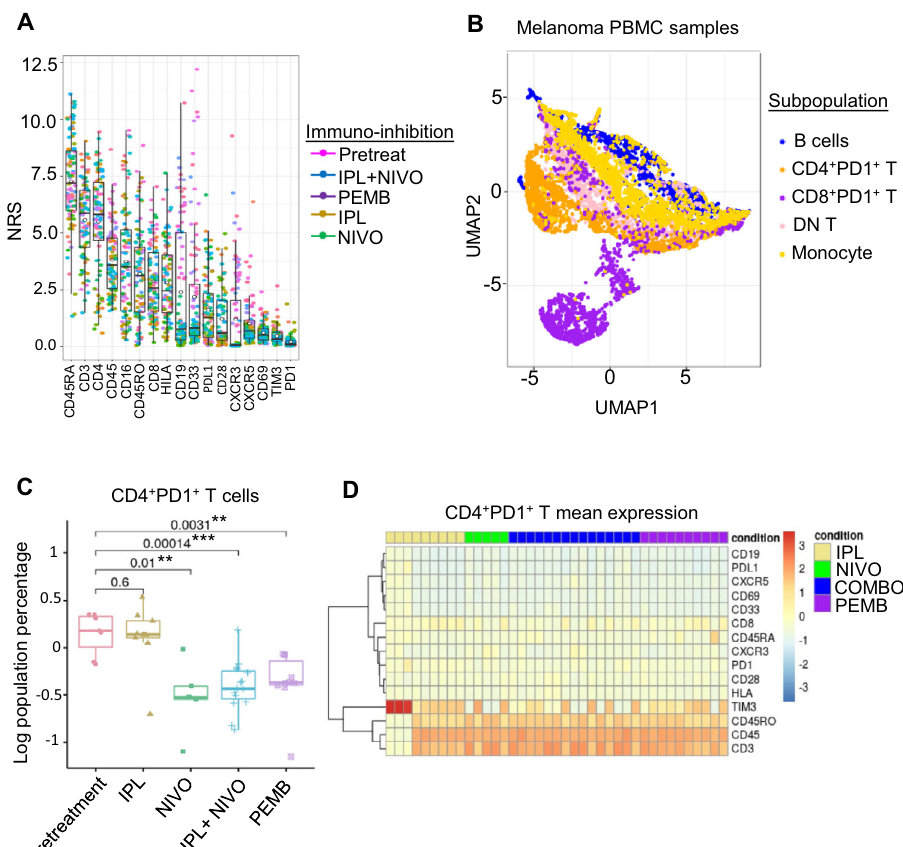
Fig. 7 Integration of melanoma datasets to uncover cellular correlates of immunotherapy. A Channel stability determination using a PCA-based non- redundancy score to rank order marker variability among melanoma PBMC samples under immunotherapy from two independent melanoma datasets ( n = 74). The band indicates the median, the black circle indicates the mean, the box indicates the fi rst and third quartiles and the whiskers indicate ± 1.5 × interquartile range. Dataset 1 contains pretreatment and Pembrolizumab (PMB)-treated PBMCs and dataset 2 contains Pembrolizumab (PMB), Nivolumab (NIVO), Ipilimumab (IPL), or a combination of IPL and NIVO-treated PBMC samples. B tSNE visualization of 8 major melanoma PBMC subpopulations based on gating strategy de fi ned in dataset 1. C Comparison of CD4 + PD1 + T cell abundance in pretreatment ( n = 7) or immunotherapy treated patients with IPL ( n = 9), NIVO ( n = 5), IPL + NIVO ( n = 15), or PEMB ( n = 10) after 3 weeks of treatment using a two-sided Wilcoxon test ( p - values: *<0.05, **<0.01, ***<0.001). The band indicates the median, the box indicates the fi rst and third quartiles and the whiskers indicate ± 1.5 × interquartile range. D Expression of 15 markers within the CD4 + PD1 + T cells. The colors are scaled based on the expression ratio of treatment to pretreatment